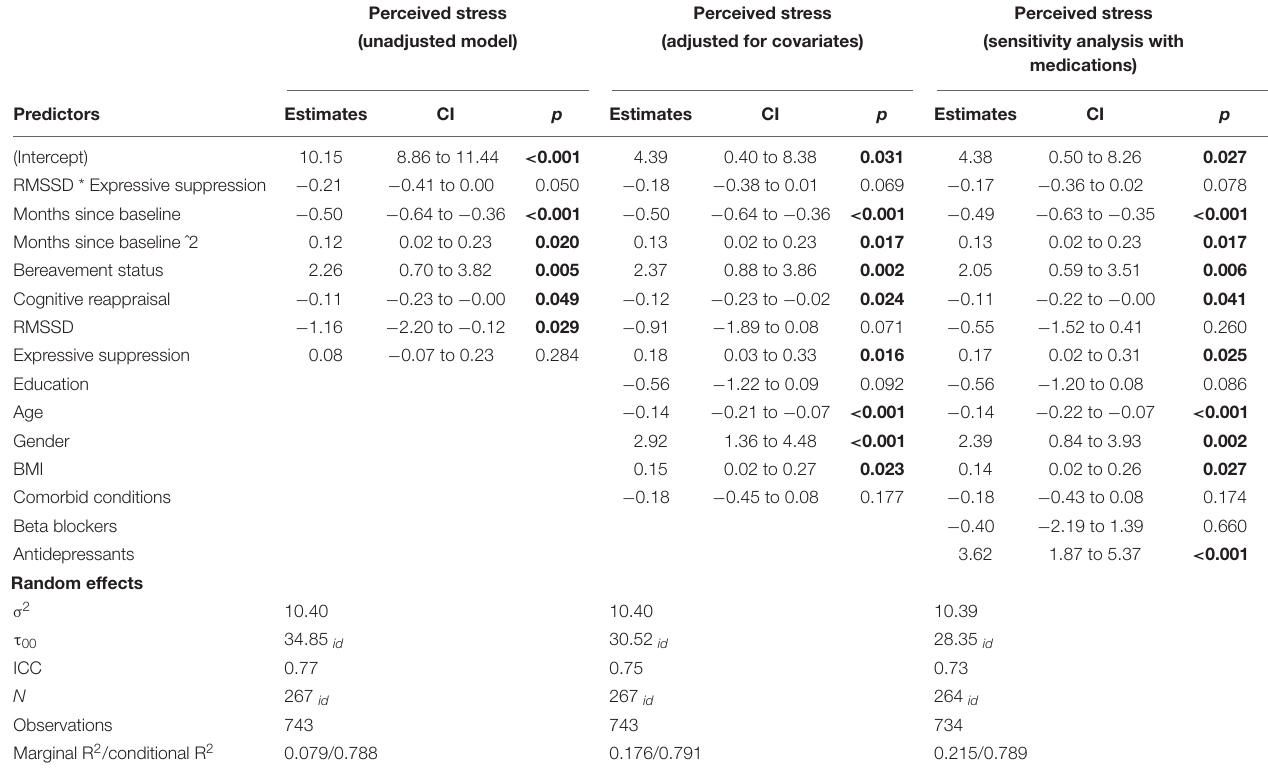
2 Indicates the squared, quadratic effect of time. Bold values indicate significant effects. The symbol “*” indicates the interaction between these two